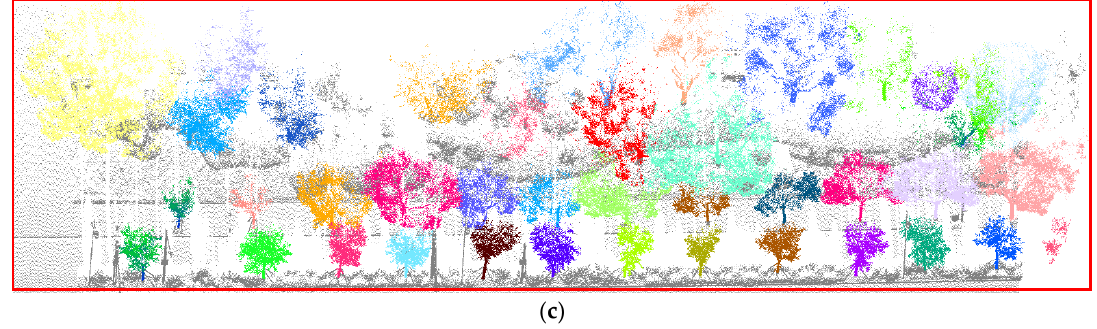
Figure 9. Example of individual tree segmentation on Dataset II. (a) Input tree point cloud, where green and gray points represent points from trees and non-tree objects, respectively, (b) individual tree segmentation result, dotted in different colors, (c) two close-up individual tree segmentation results at some selected regions.